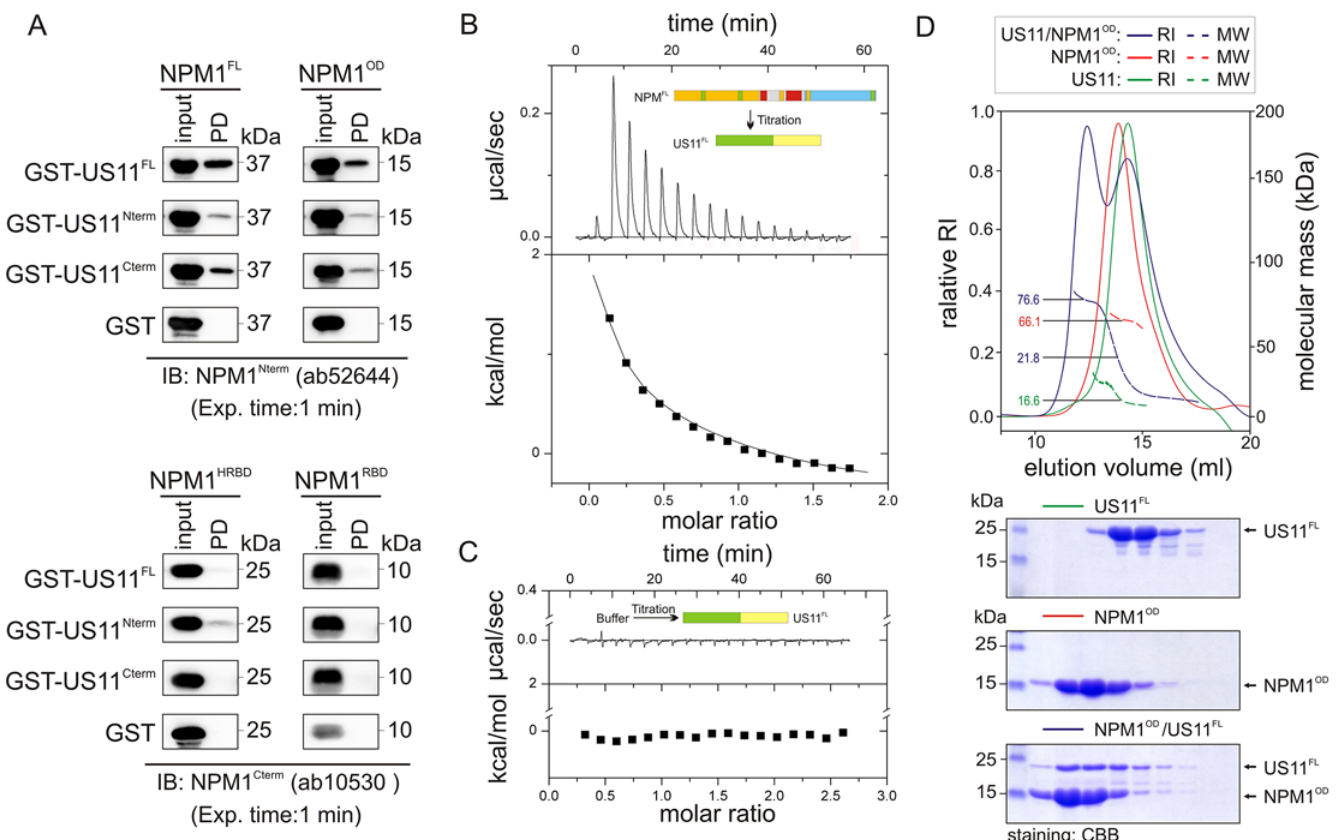
Fig 4. Physical interaction of HSV-1 US11 with NPM1. (A) C-terminal region of US11 largely contributes to NPM1 interaction. Pull-down experiments were conducted with purified proteins in the presence of RNase A by using GST-fused US11 FL , US11 Nterm , US11 Cterm , and GST as a negative control. For the detection of NPM1 variants two different antibodies were used, ab52644 recognized an N-terminal epitope containing in NPM1 FL and NPM1 OD , and ab10530 recognized a C-terminal epitope containing in NPM1 HRBD and NPM1 RBD . The same pattern of interaction was obtained for the N-terminal and the C-terminal parts of US11, although the interaction between NPM1 FL and NPM1 OD with US11 Nterm was much weaker than with US11 Cterm . The exposure time was 1 min for all the blots. (B-C) US11 binds NPM1 with a binding constant in the low micromolar range. To measure the binding parameter for the NPM1-US11 interaction, 1.2 mM NPM1 FL (B) and buffer (C) were titrated to 60 μ M US11 FL . Both NPM1 and US11 were treated with RNase A. Conditions were the same as described in Fig 2. US11 binding to NPM1 is an endothermic reaction. (D) US11 binds to a pentameric NPM1. aSEC-MALS/RI analysis of NPM1 OD , US11 FL , and a mixture of both proteins revealed an oligomeric nature of NPM1 OD with a molecular weight (MW) of 66.1 kDa corresponding to the pentameric form. Obtained MW for US11 was 16.6 kDa, which matches the theoretical MW of 16.7 kDa for a monomeric US11 (upper panel). SDS-PAGE and CBB staining of the aSEC (Superdex 200, 10/300) elution fractions of NPM1 OD , US11 Fl , and a mixture of both clearly revealed a NPM1-US11 complex formation (lower panel). Both NPM1 and US11 were treated with RNase A. The MW of this complex corresponds to 76.6 kDa for a pentameric NPM1 OD , and a monomeric US11 FL . A MW of 21.8 kDa was measured that is estimated to an unbound US11 FL